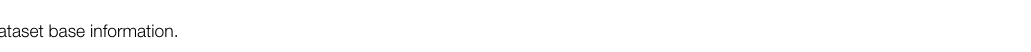
TABLE 1 | Dataset base information.